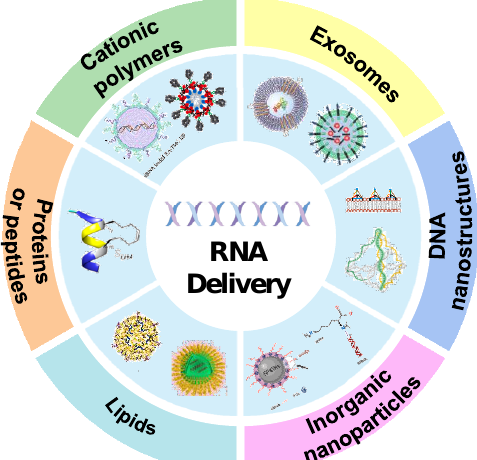
Figure 1. Different RNA delivery carriers in cancer therapy. These delivery vehicles include cationic polymers, exosomes, DNA nanostructures, inorganic nanoparticles, lipids, proteins or peptides, etc.